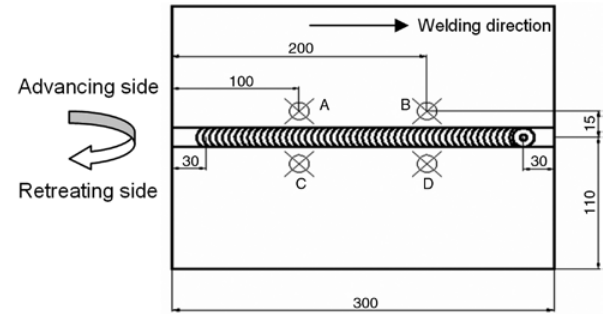
Figure 2: Thermocouple locations on